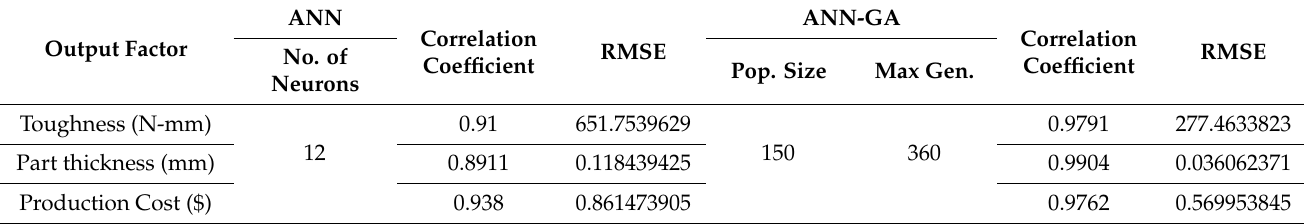
Table 10. Results for the testing